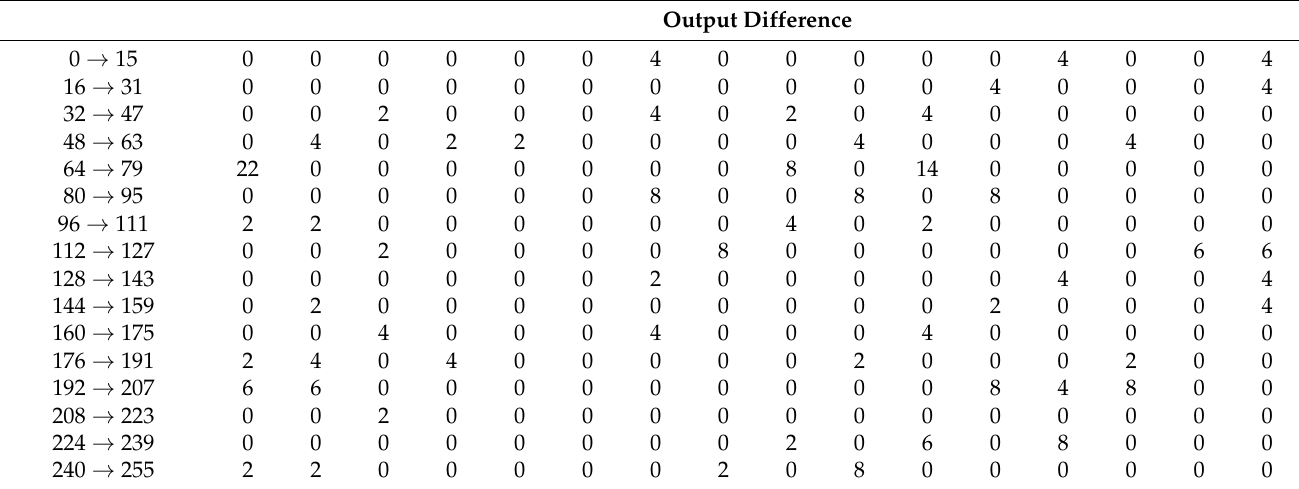
Table 4. Difference distribution table for input difference ∆ X = {0, 1, 1, 1, 1, 0, 0, 0}. Output